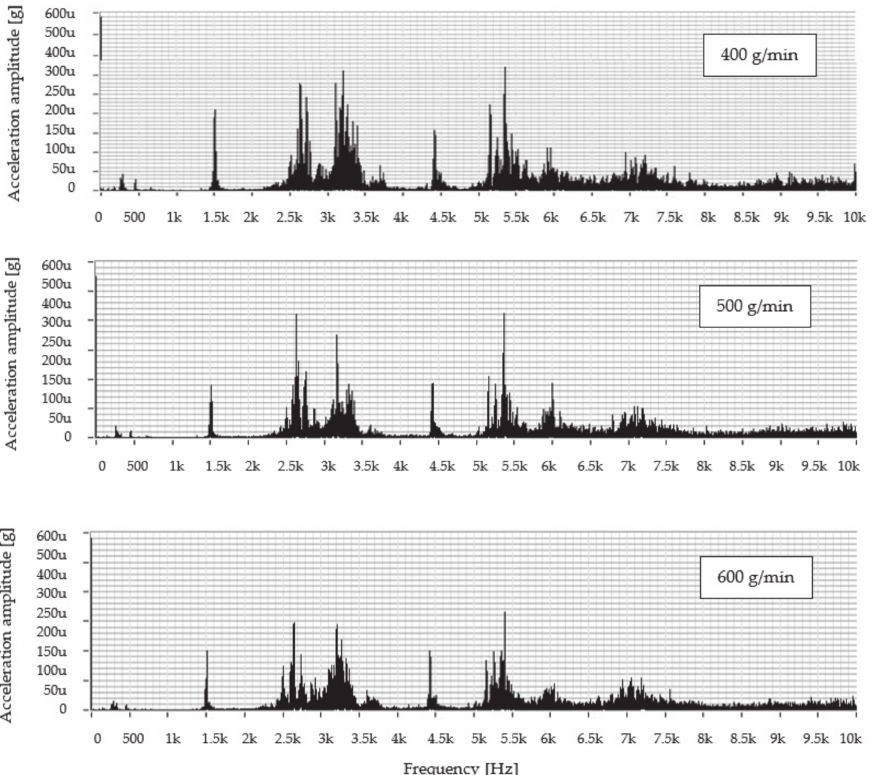
Figure 4. Frequency spectra of vibration acceleration amplitude versus frequency for abrasive mass flows at a feed rate of 50 mm/min for abrasive